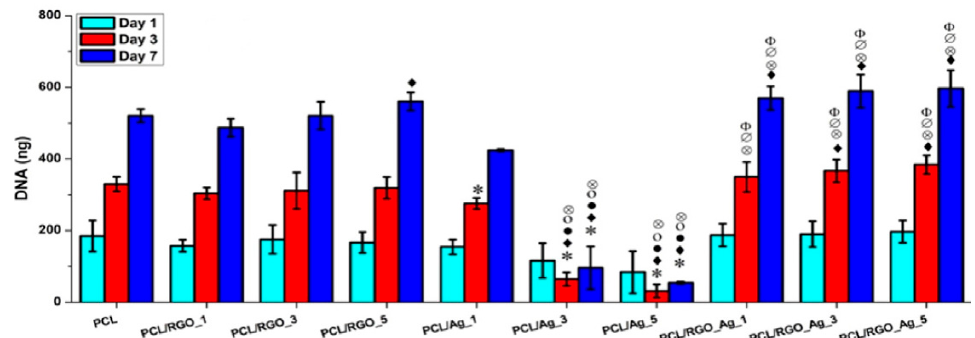
Figure 30. DNA quantification of hMSCs cultured on PCL and its composites for 1, 3 and 7 days. Statistically significant differences ( p < 0.05) compared to PCL, PCL/RGO_1, PCL/RGO_3, PCL/RGO_5, PCL/Ag_1 and PCL/Ag_3 and PCL/Ag_5 are indicated by *, ♦ , •, ο , ⊗ , ∅ and Φ , respectively. Reproduced with permission from [187], Copyright Elsevier, 2016.